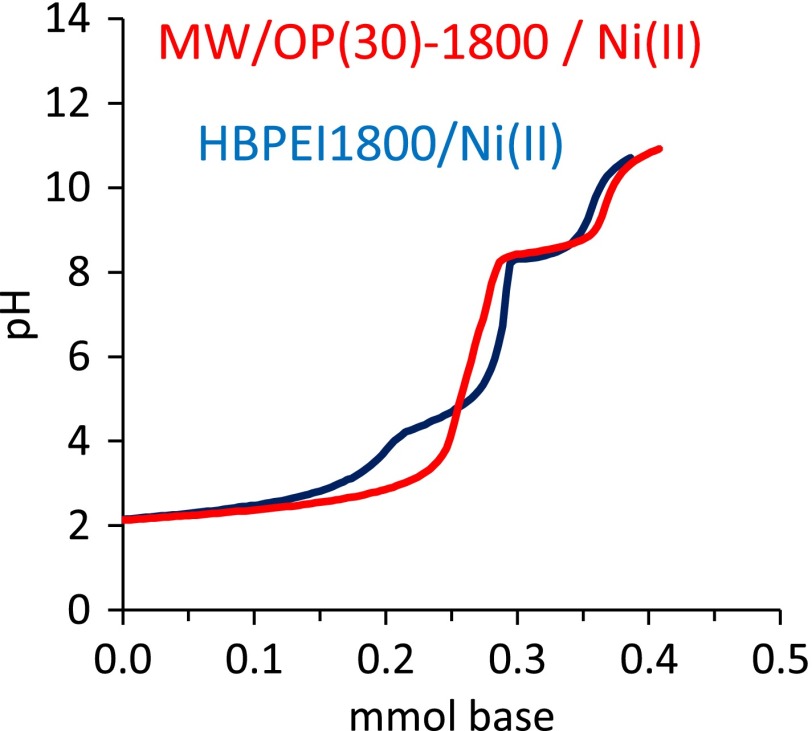
Ni2+ titration plots of the free HBPEI1800 (blue line) and of one hybrid (red line).